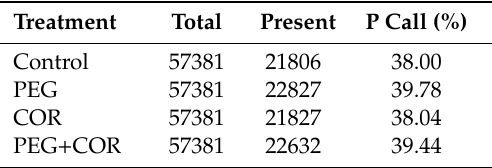
Table 2. Percent of present probe in four